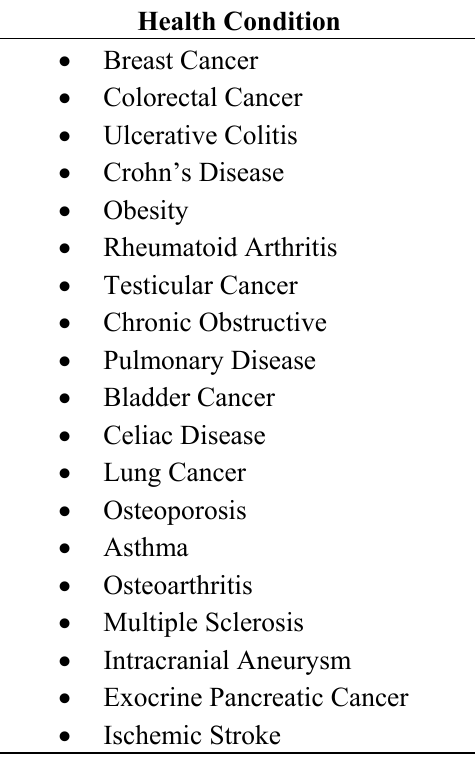
Table 2. Additional Coriell Personalized Medicine Collaborative (CPMC ® ) approved health conditions for prospective